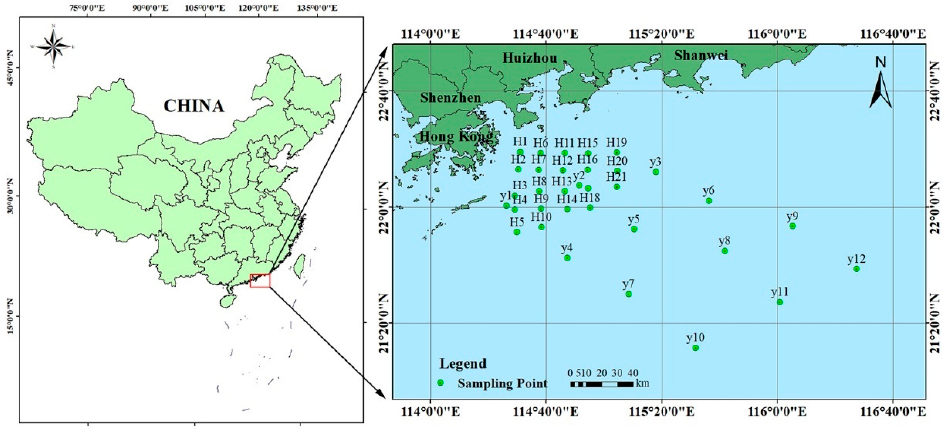
Figure 1. Study area and sampling sites.